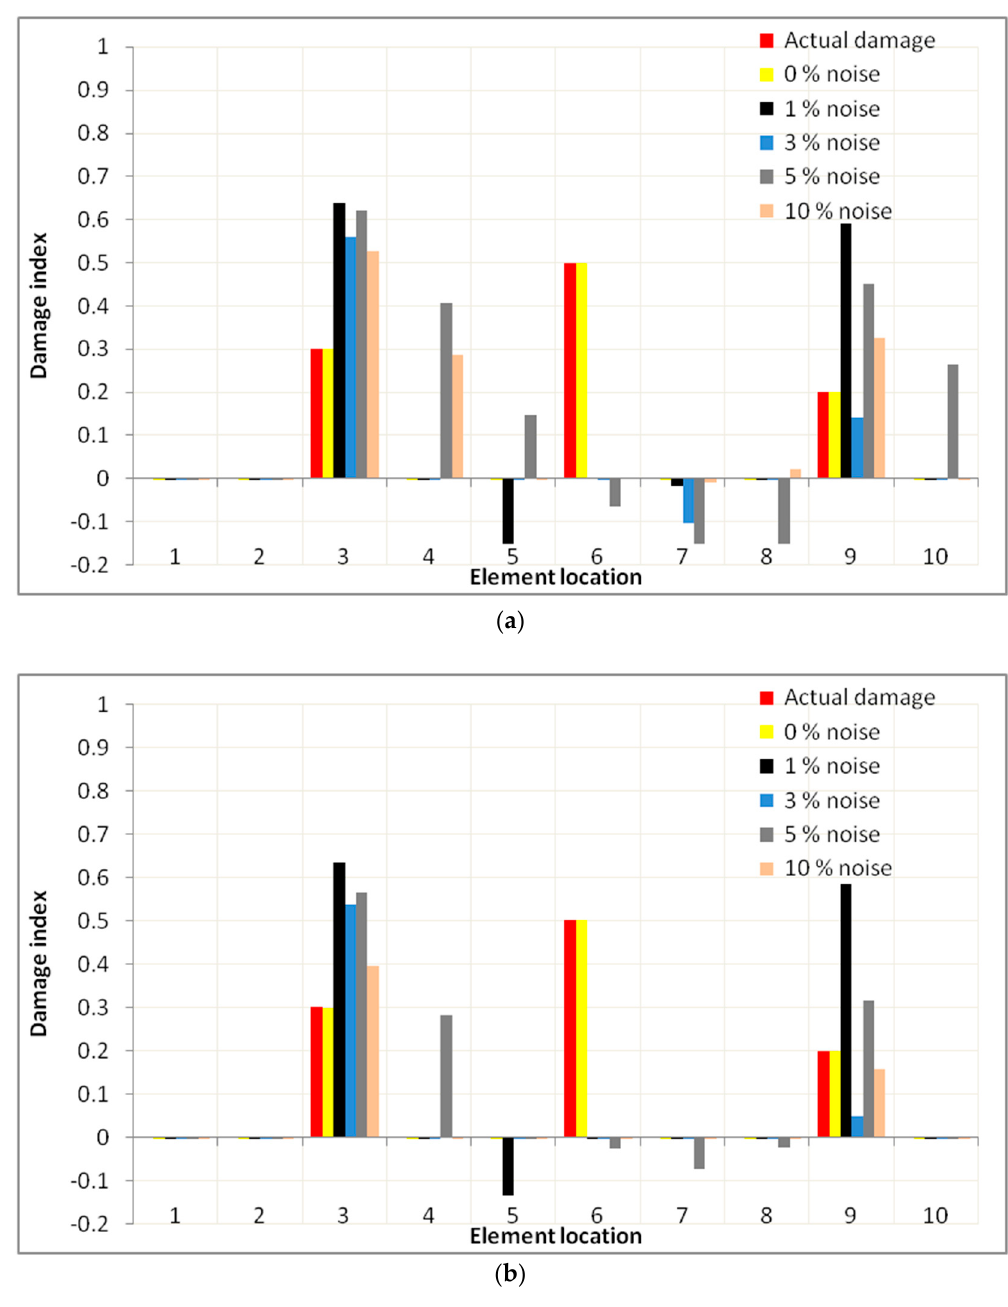
Figure 13. Damage distribution for Case 2 using Objective Function II with regularization for ( a ) noise both in frequency and mode shapes and ( b ) noise in mode shapes only.